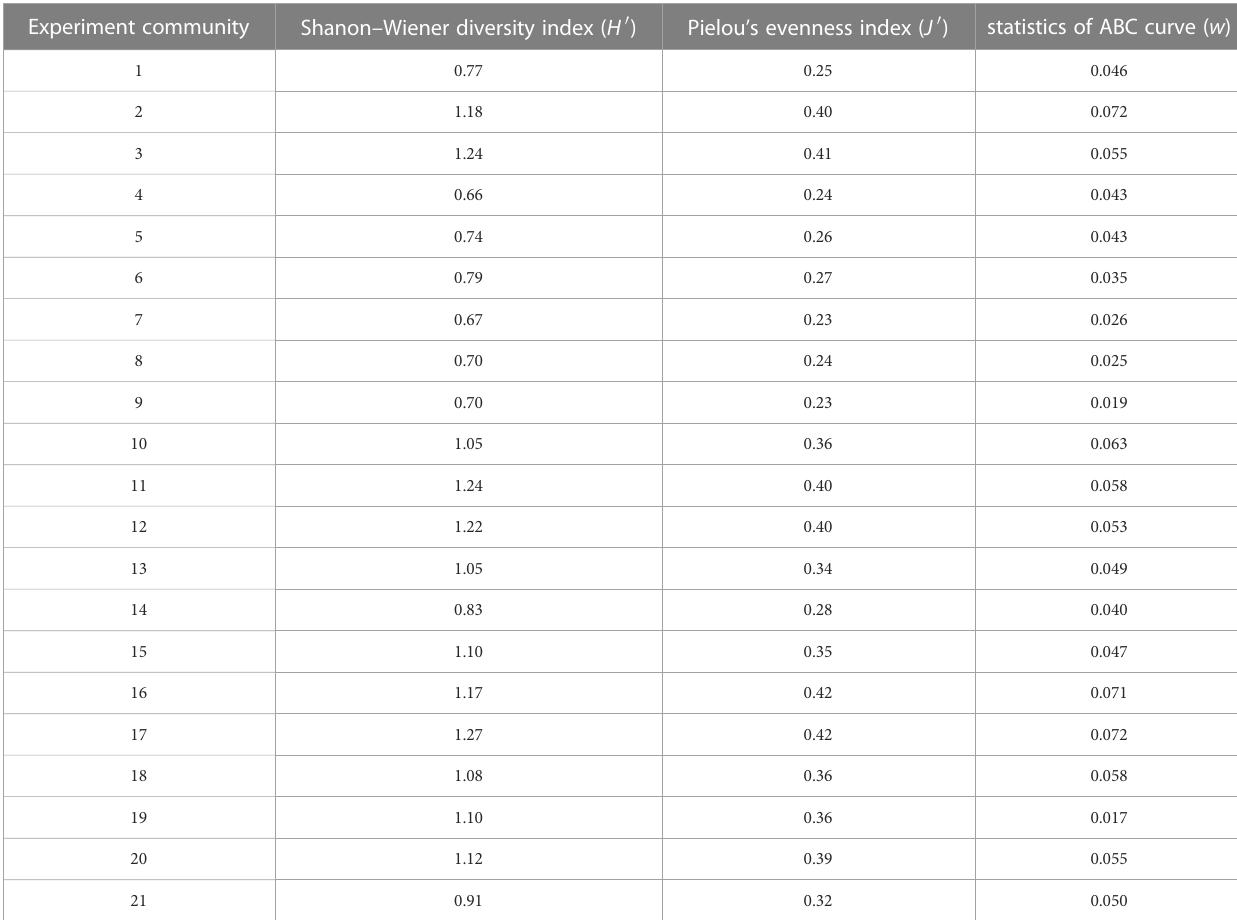
TABLE 5 Indications of macrobenthos community. Experiment